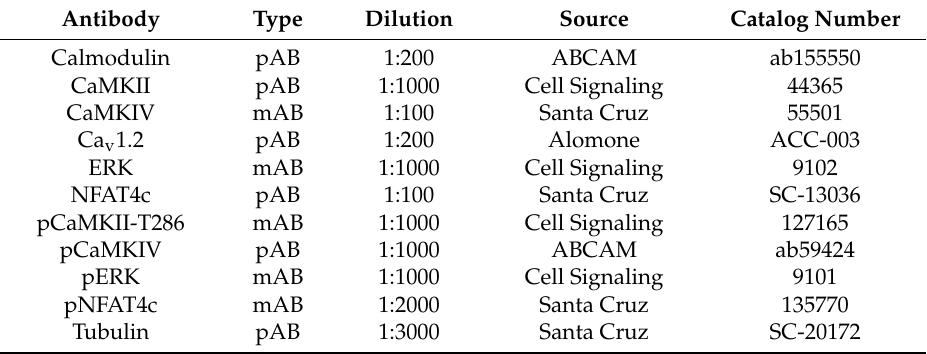
Table 2. List of